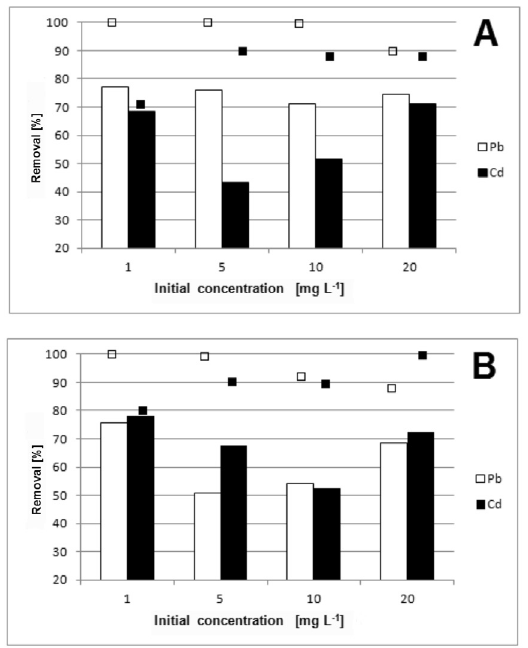
Figure 4. The effect of a co-occurrence of equivalent concentrations of Cd and Pb on their biosorption by M. aeruginosa after 3 h (A) and 6 h (B) of contact. White and black squares indicate removal level reached in a single metal